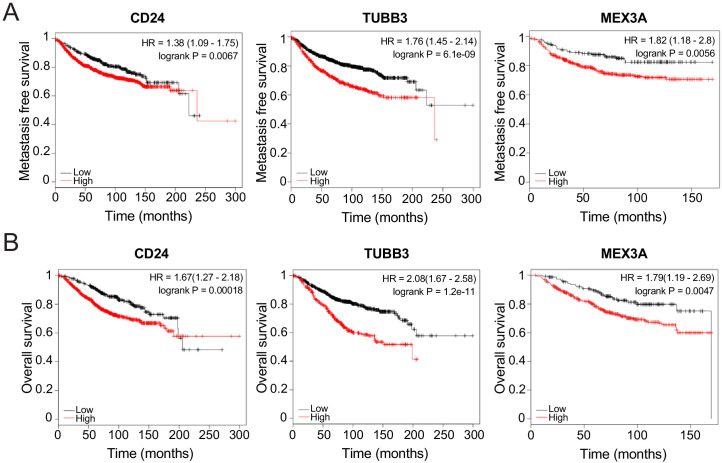
Survival curves of breast cancer patients with tumours expressing low or high levels ofCD24,TUBB3, andMEX3A.(A) Distant metastasis-free survival of breast cancer patients with low or high expression of CD24, TUBB3, and MEX3A. (B) Overall survival of breast cancer patients with low or high expression of CD24, TUBB3, and MEX3A.